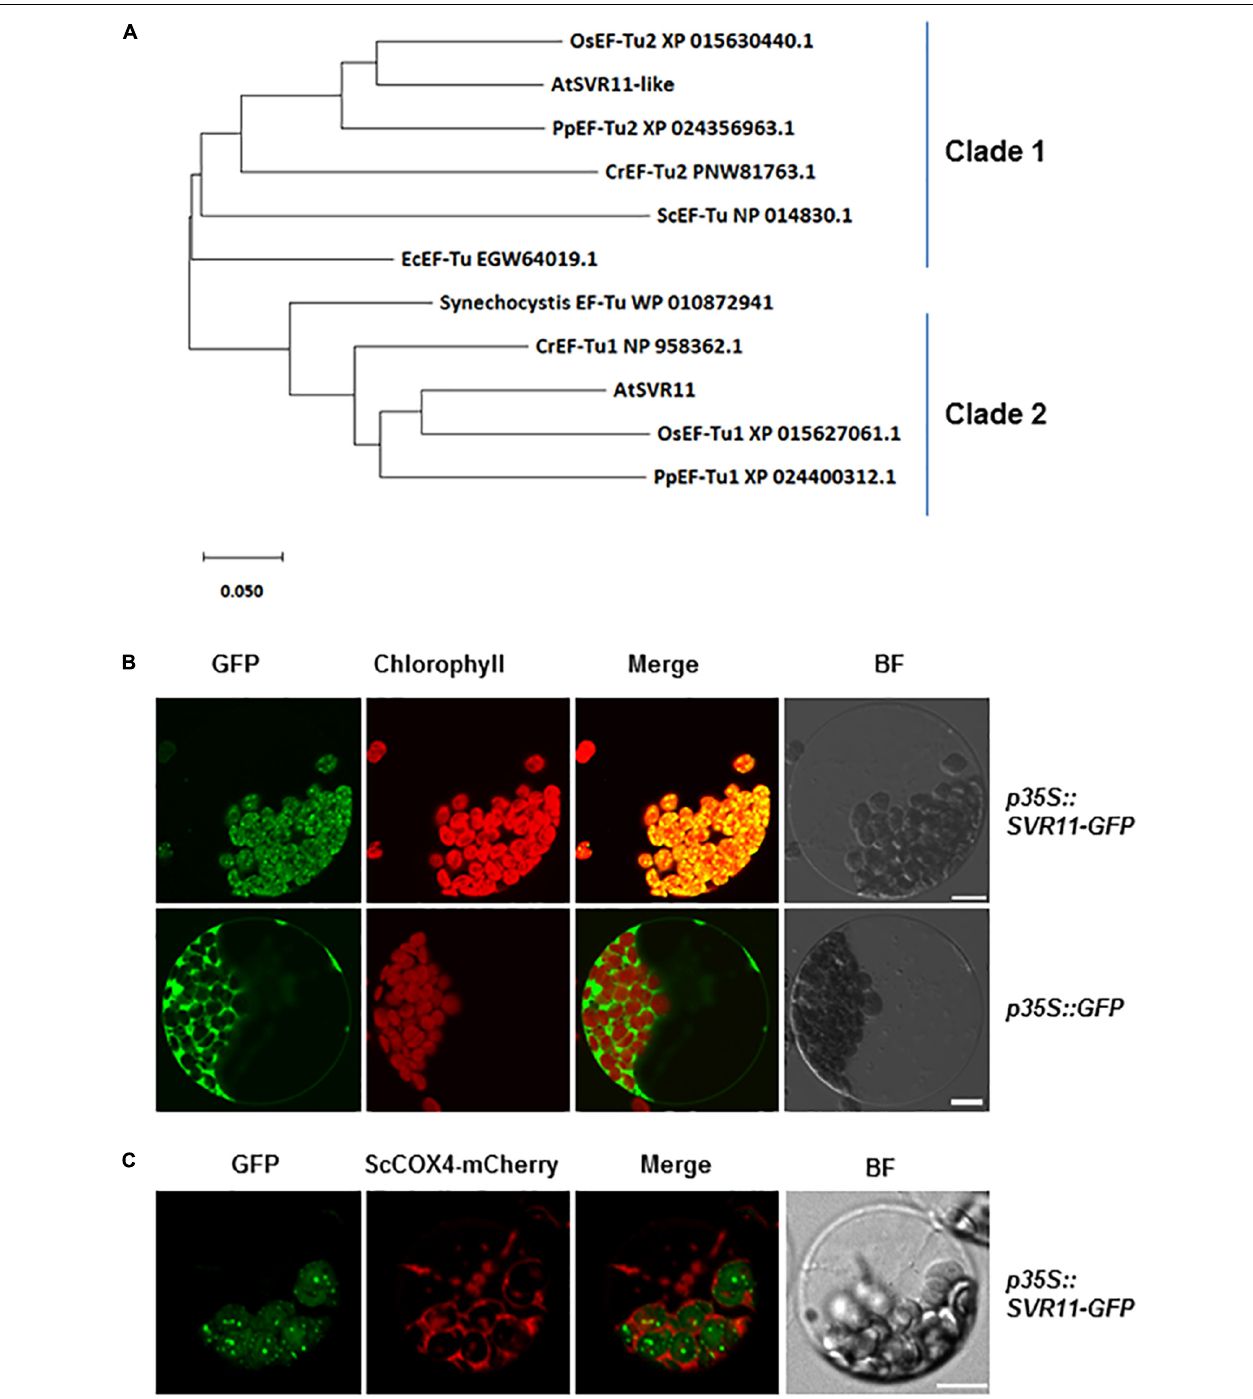
FIGURE 3 | Evolutionary relationships of SVR11 homologs and subcellular localization of SVR11. (A) Phylogenetic analysis of the SVR11 protein family. Full-length protein sequences of SVR11 homologous proteins of different species indicated by the accession numbers were obtained from NCBI using BLASTP. The neighbor-joining algorithm was used to generate the initial tree. (B) Leaf protoplasts prepared from wild type Arabidopsis plants were transformed with the p35S::SVR11-GFP fusion construct or the control construct p35S::GFP. Confocal microscopy was used to monitor fluorescence signals from the GFP channel (500–550 nm) and chlorophyll autofluorescence (663–738 nm). Bright field (BF) images served as controls for protoplast integrity. (C) Transient expression of p35S::SVR11-GFP fusion protein in protoplasts isolated from plants expressing a mitochondrion marker ScCOX4-mCherry (570–620 nm). Representative images of a single protoplast are shown. Bar stands for 10 µ